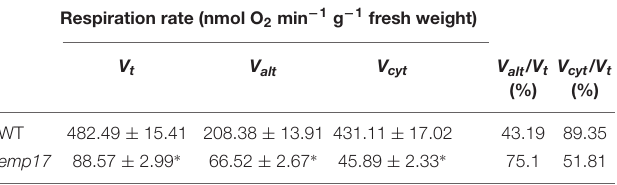
ortholog in O . sativa , A . thaliana , B . napus , G . hirsutum ,